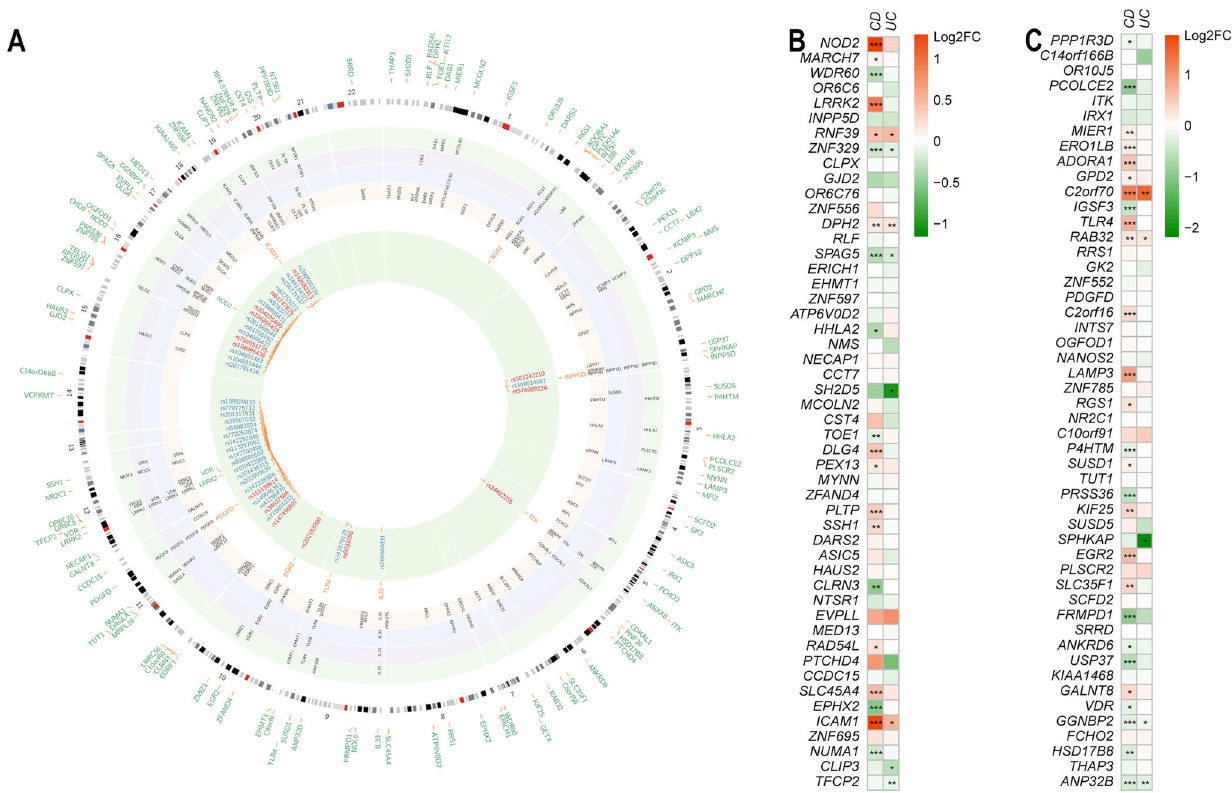
Fig. 2 | Pathway approaches prioritized IBD-associated genes derived from case-controlstudies,anddifferentialexpressionofIBD-associatedgenesinCD, UC vs. controls. A A Circos plot summarizes the process of identifying IBD- associated genes and variants. The outer layer includesall 127SKAT-O-derived IBD candidategeneswith P <0.01.Theintermediatefourlayersrepresentthetopgenes identi fi edbyfourdifferentpathwayenrichmentandbiologicalrelatednessanalyses (green: ToppGene; purple: Human Gene Connectome; blue: GIANT; yellow: Inge- nuity Pathway Analysis). The 11 genes listed between the intermediate layers and the inner green layer are signi fi cant gene loci identi fi ed in common by all four pathwayapproaches (the three known IBDgenes are ingreen, the 8 novel genes in orange). The inner layer displays all 46 high-impact rare variants in the 11 orange genes. Of the 46 variants, 14 variants (highlighted in red inside the inner green